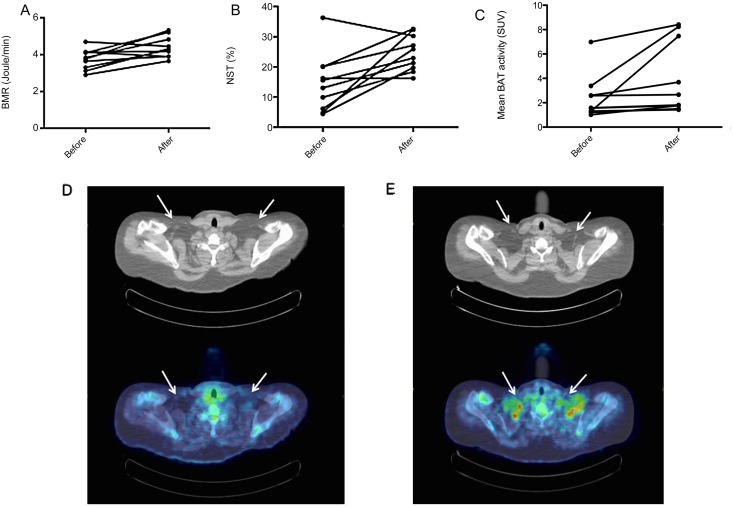
BAT activity, BMR and NST before and after levothyroxine therapy.Brown adipose tissue (BAT) activity before and after levothyroxine substitution therapy. (A) Basal metabolic rate (BMR) in joules per minute. (B) Non-shivering thermogenesis (NST) before and after levothyroxine replacement therapy. (C) BAT activity in Mean Standard Uptake Values (SUV mean) before and after levothyroxine therapy. Subject indicated with X is also depicted in Fig 2D and 2E. (D) Transversal CT (top) and PET/CT fusion (bottom) slice of the supraclavicular region demonstrating 18F-FDG-uptake in BAT locations (white arrows) after cold exposure in hypothyroid state. (E) Transversal CT (top) and PET/CT fusion (bottom) slice of the supraclavicular region demonstrating 18F-FDG-uptake in BAT locations (white arrows) after cold exposure in subclinical hyperthyroid state.